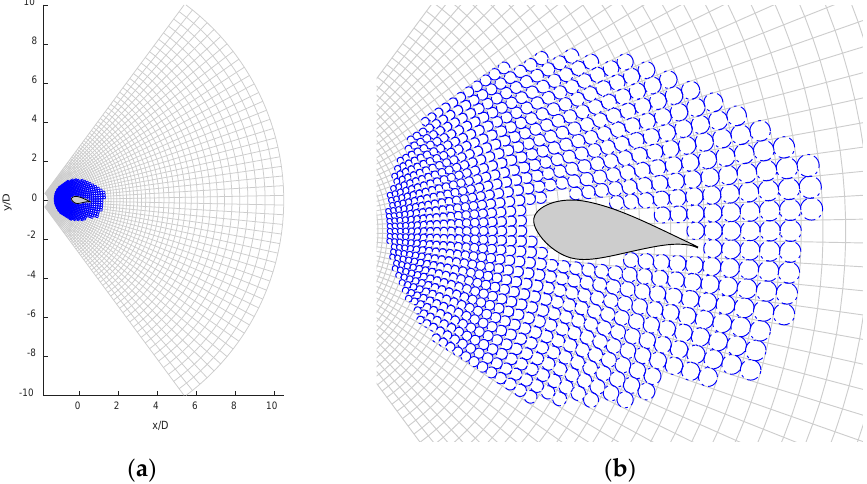
Figure 2. Schematic description of the vortex particles initialized on the varying-sized grid for Re C = 500: ( a ) Entire domain. ( b ) Close view of particles near the airfoil.